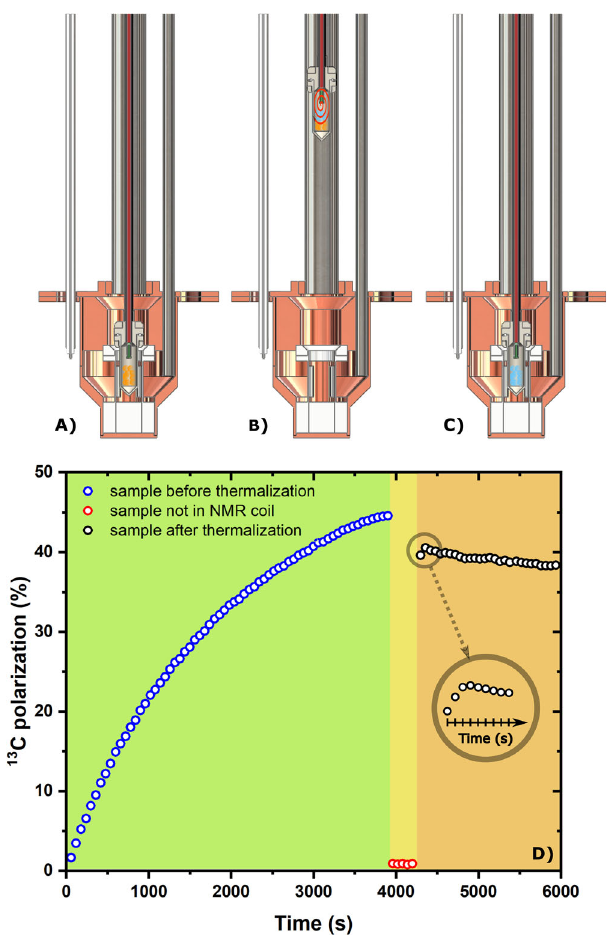
Fig. 2 Different steps of a radical scavenging experiment at 6.7 T and 1.2